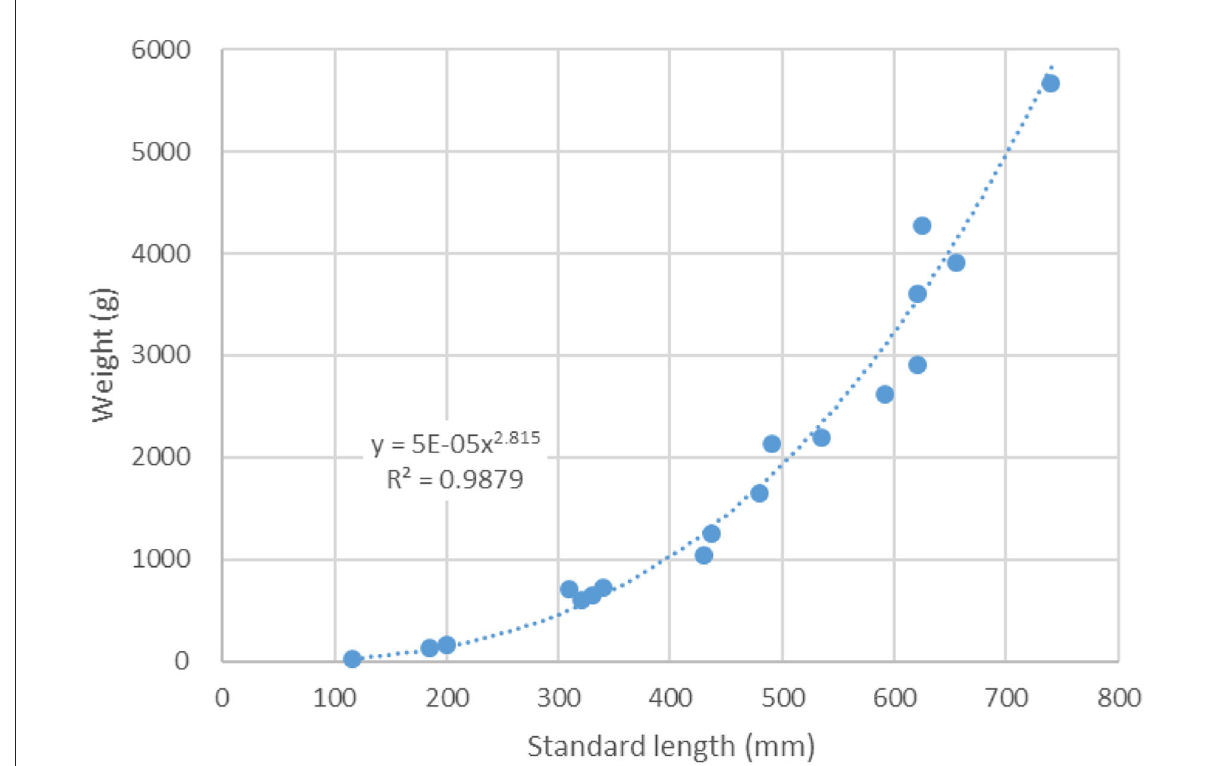
FIGURE4 Standard length (SL) to weight (W) relationship of the modern sample of Lateolabrax maculatus